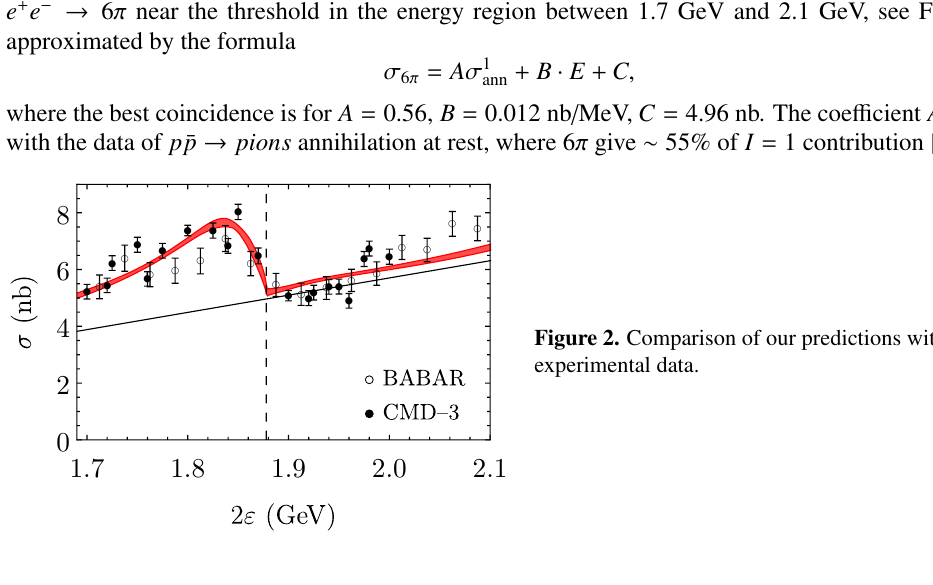
Figure 1. Left picture: the cross sections of p ¯ p (red line) and n ¯ n (green line) production; right picture: G p for proton. The experimental data are from BaBar [2], CMD3 [4], and SND [3].